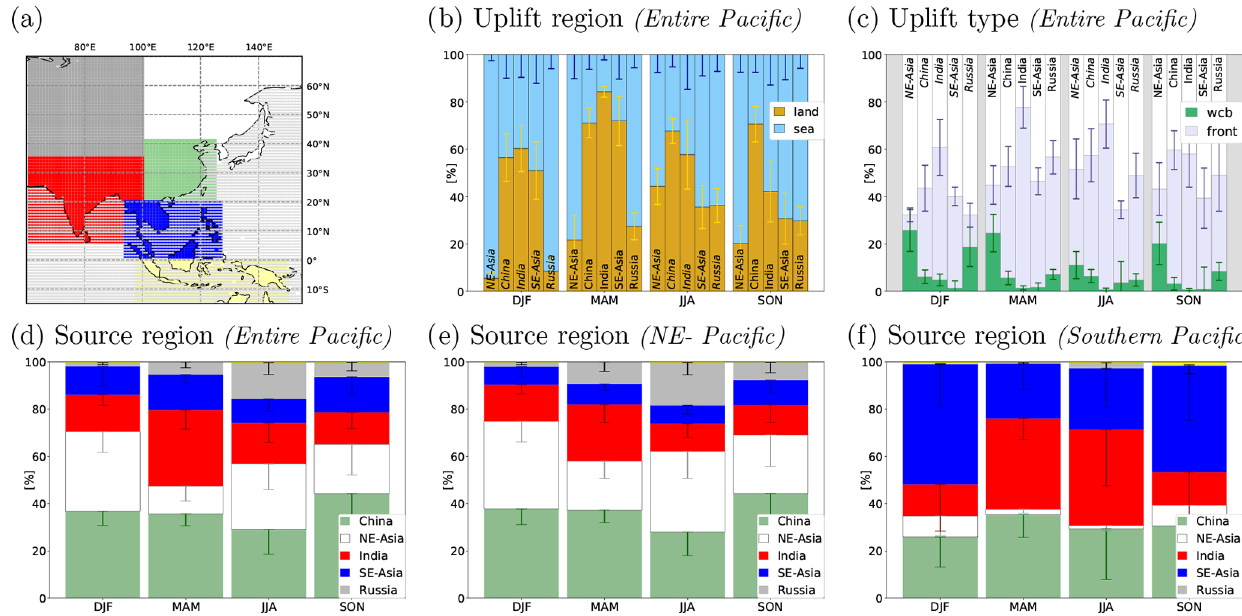
Figure 8. CO source regions are shown in (a) : China (green), NE Asia (white), India (red), SE Asia (blue), Russia (grey), and Indonesia (yellow). The contribution from Indonesia is very small and almost not visible in the bar charts. All other plots show seasonal statistics [%] of the trajectory calculations. Panel (b) shows the percentage of trajectories that rise over land or sea for each source region. The uplift type is shown in (c) . Panels (d) – (f) show the percentage of trajectories from each source region when including all CO maxima over the entire Pacific (d) , including only CO maxima north of 45 ◦ N (e) , and including only CO maxima between 0 and 30 ◦ N (f) . Vertical lines show the standard deviation (which is only plotted in the negative direction in panels d – f